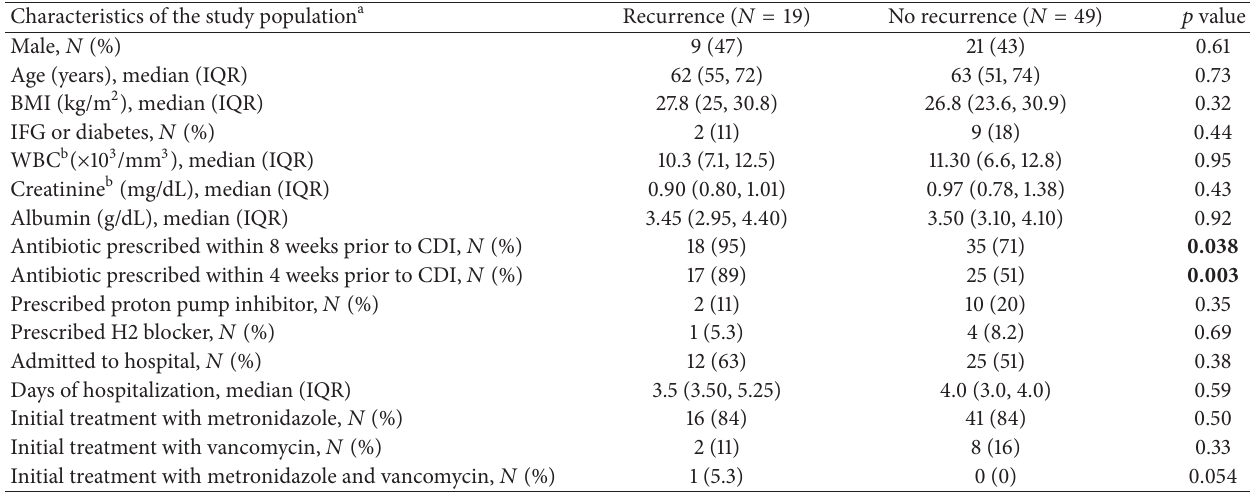
Table 1: Characteristics of the study